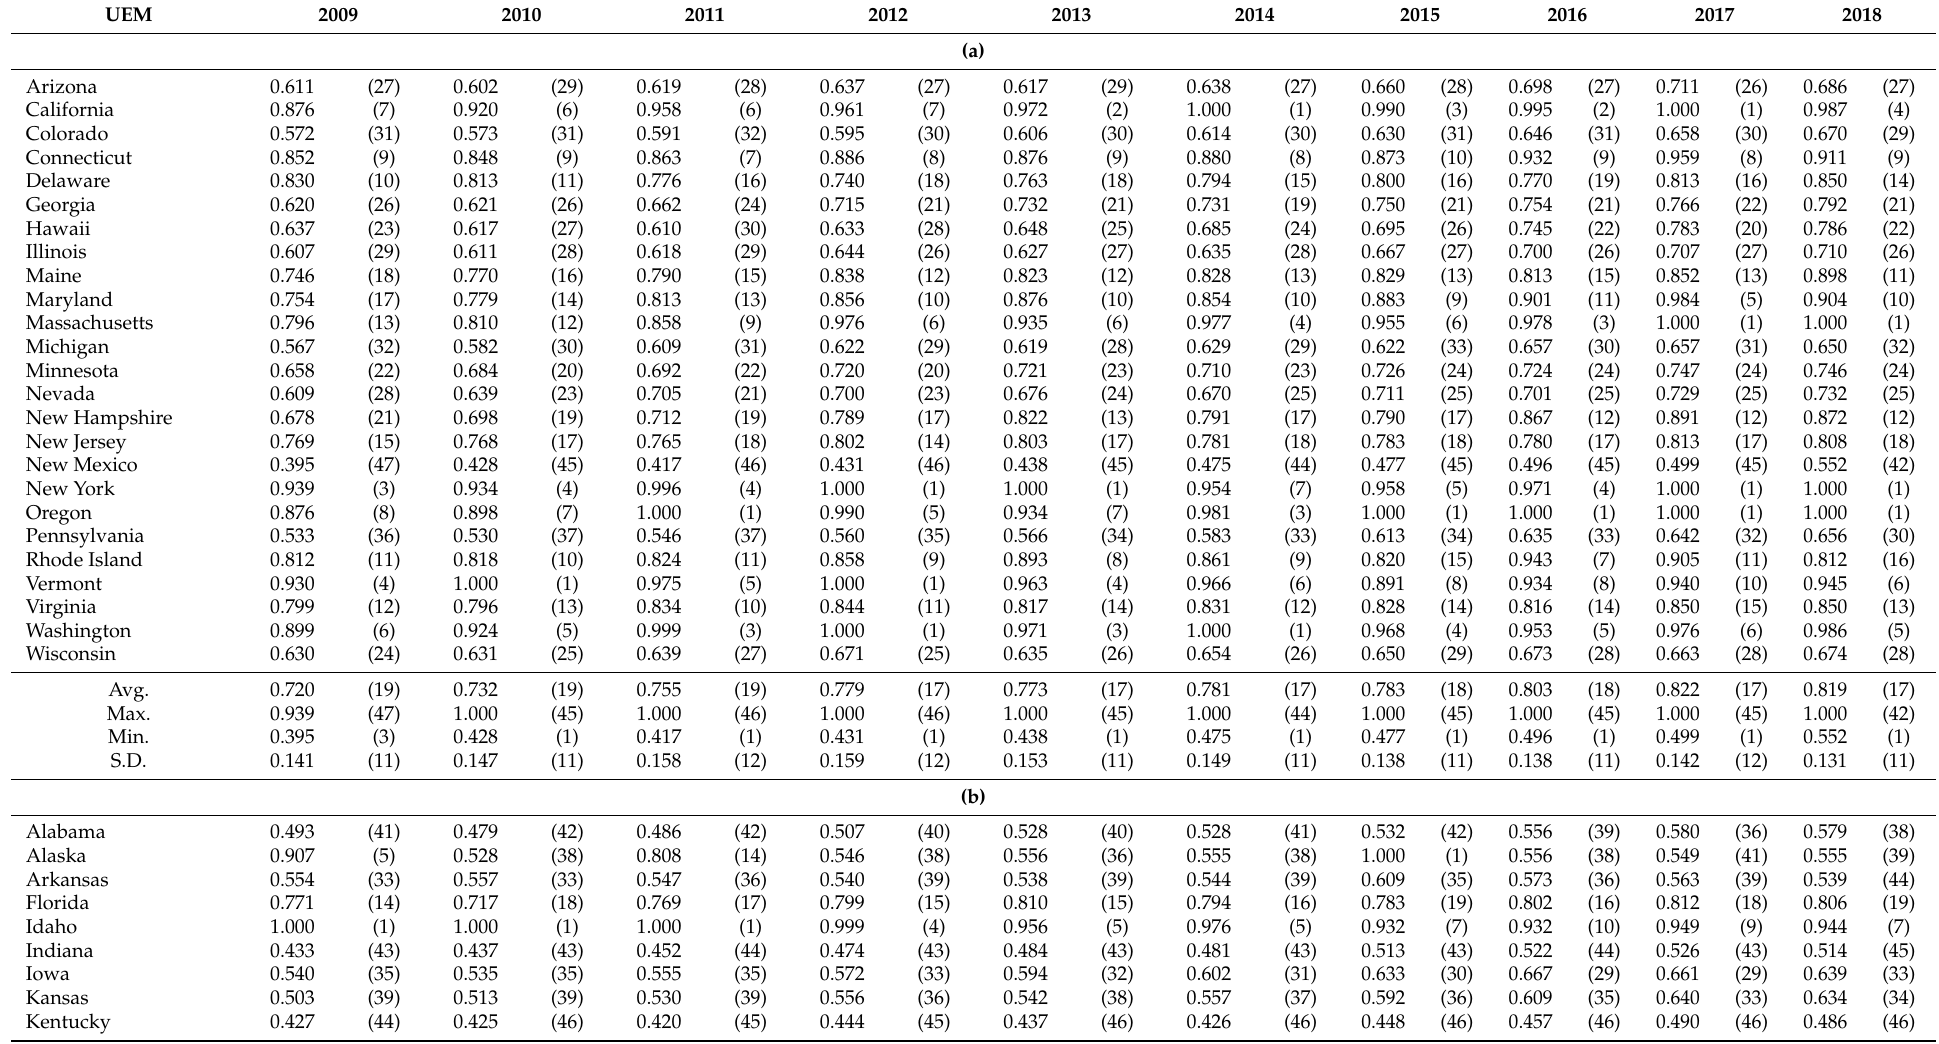
Table 6. Unified Efficiency Scores of (a) Blue States and (b) Red States from